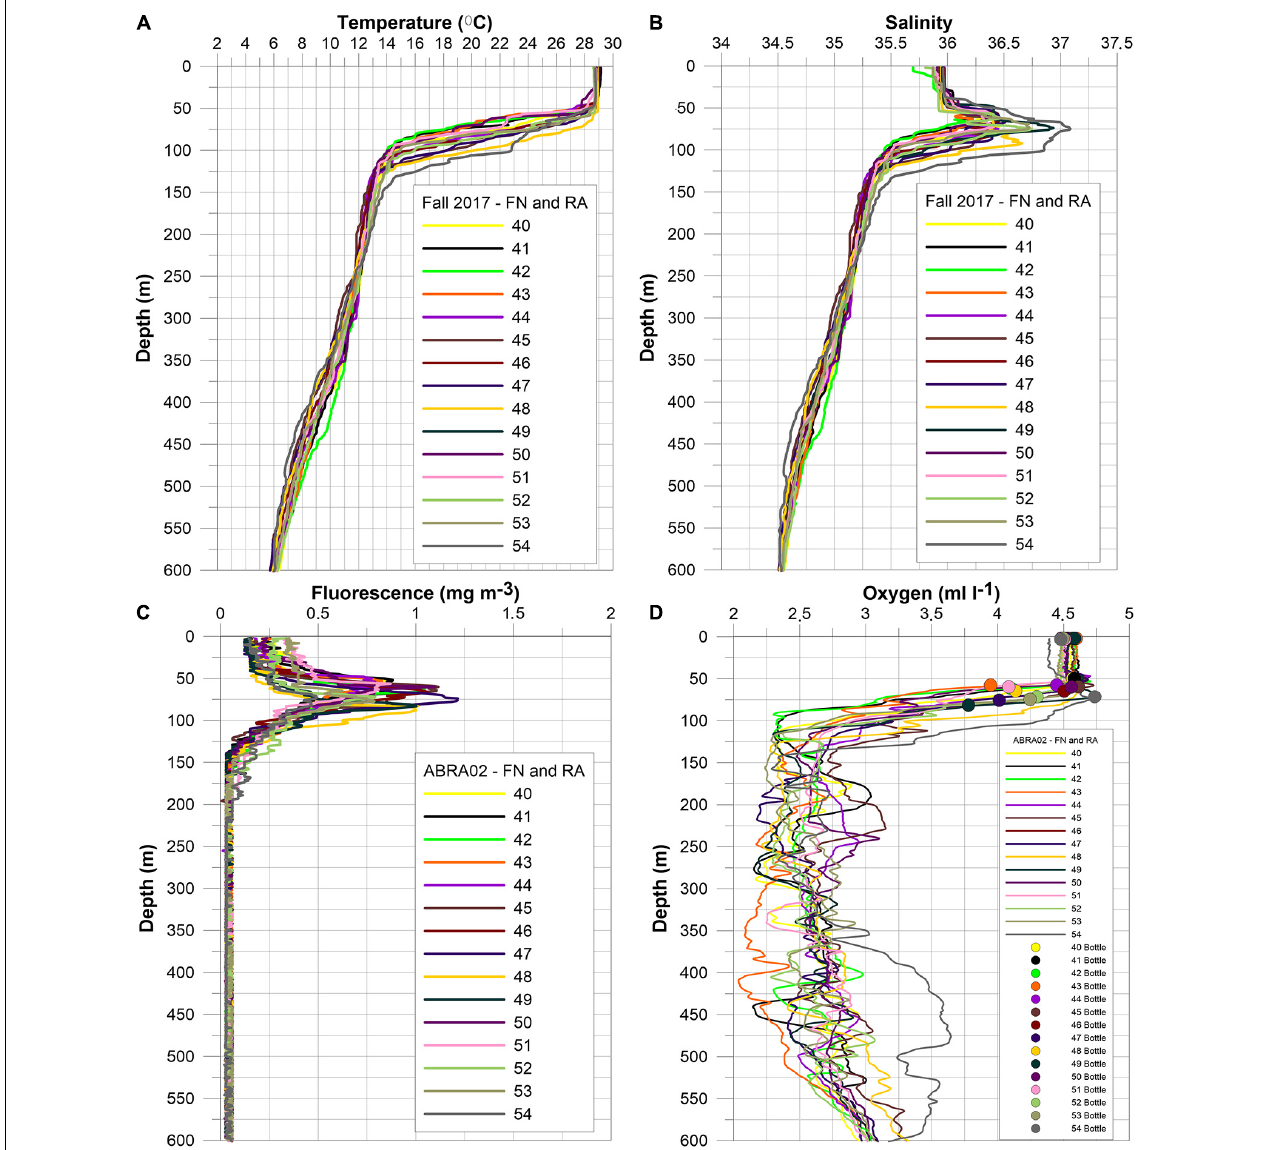
FIGURE 6 | CTD profiles obtained during the ABRACOS surveys in fall 2017 around the Fernando de Noronha Archipelago and Rocas Atoll. Vertical profiles of temperature (A) , salinity (B) , fluorescence (C) , and dissolved oxygen (D)